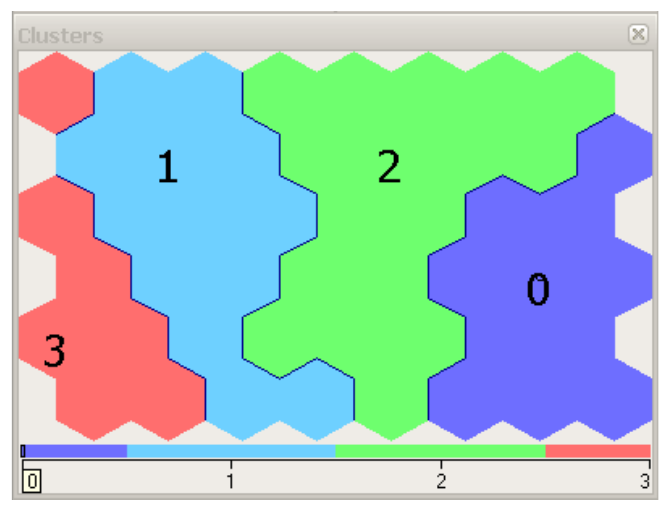
Figure 1. SOM (2014–2017). Automatic clustering